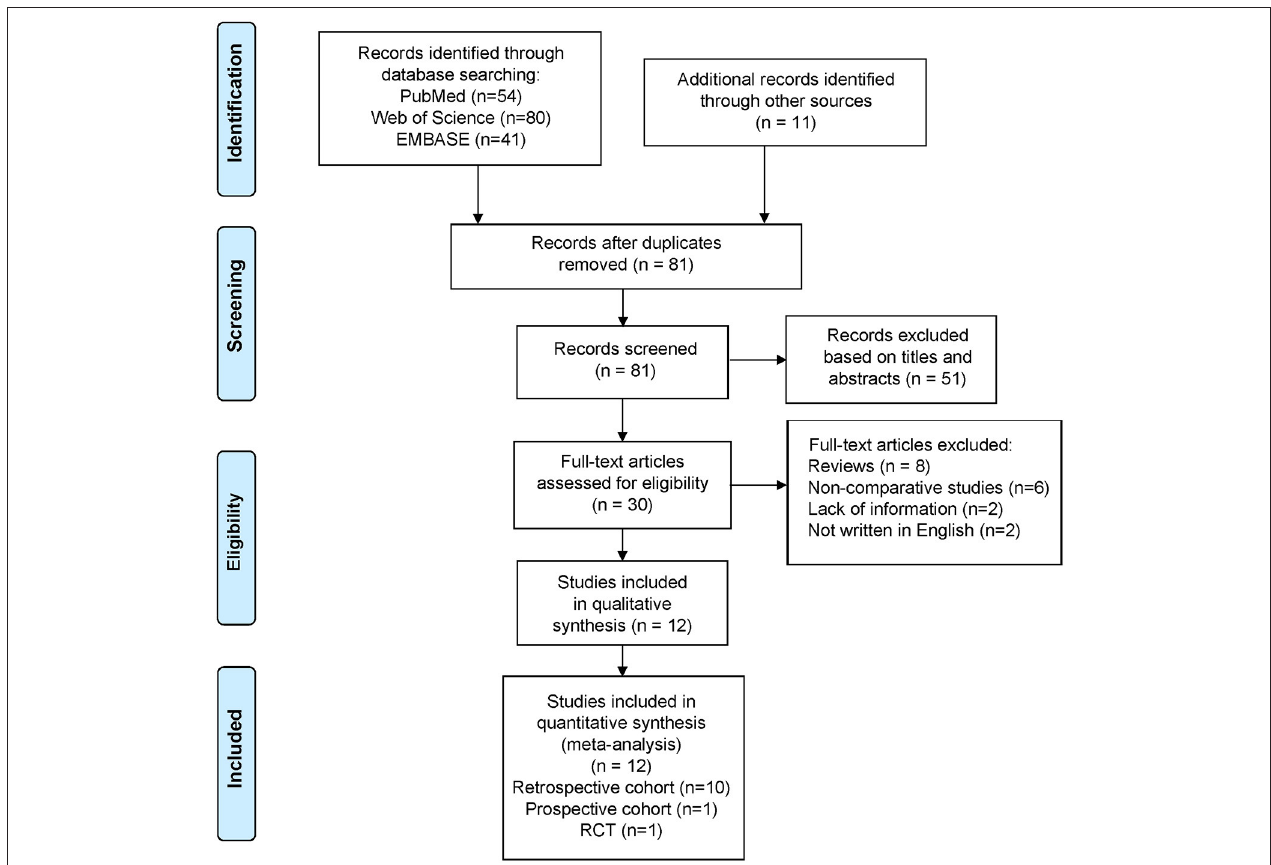
FIGURE 1 | Flowchart depicting the literature search and selection